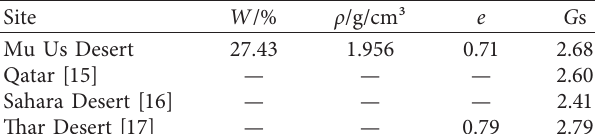
Table 2: The basic parameters of aeolian sand in different locations.